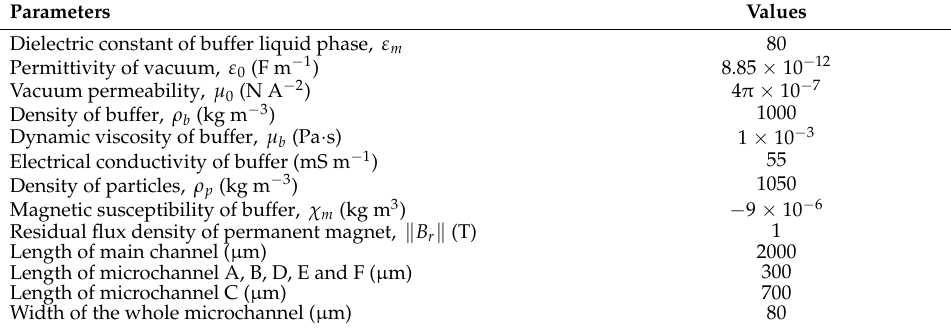
Table 1. Values of parameters used in the